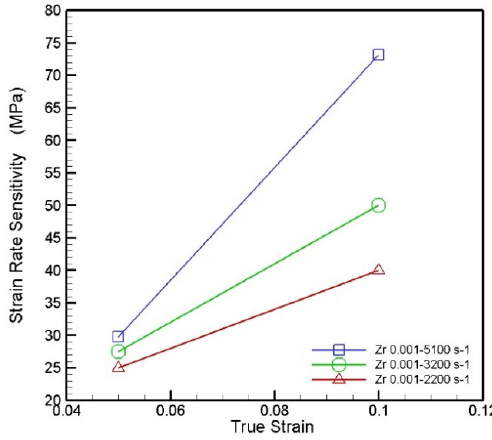
Figure 4. Variation of strain rate sensitivity with true strain as function of strain rate.